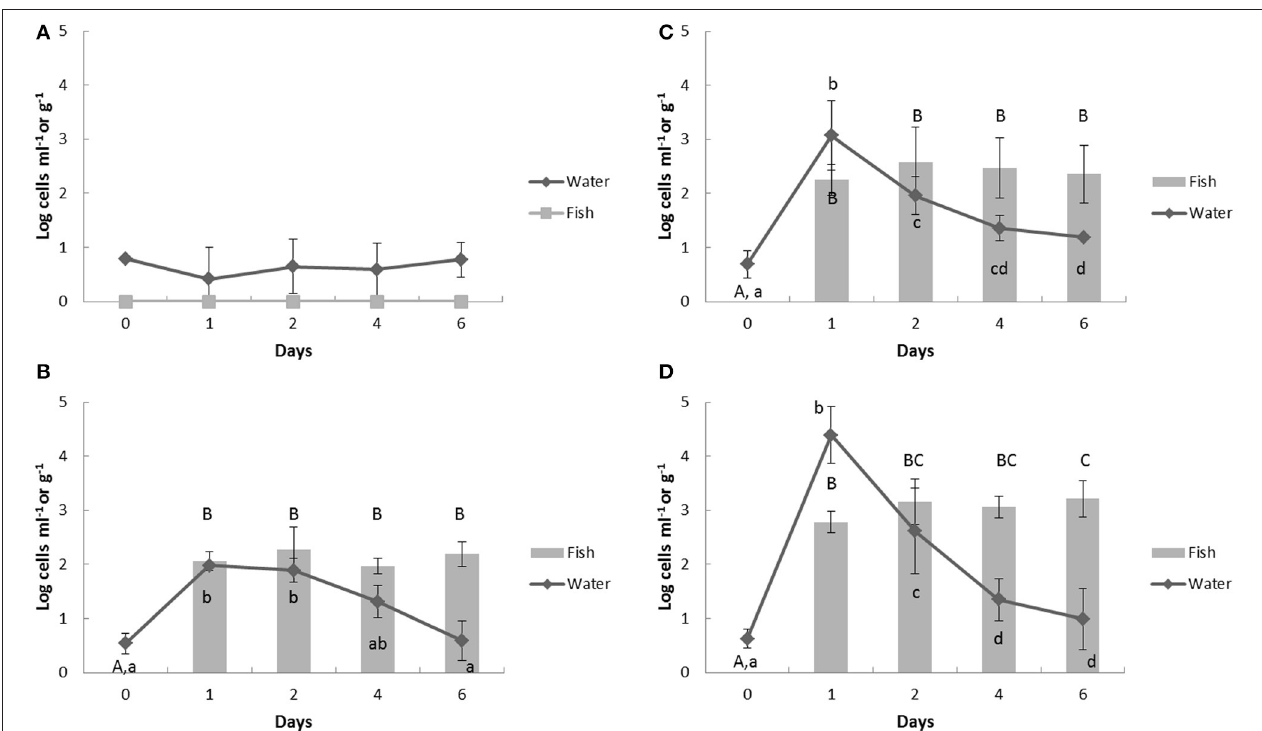
FIGURE 4 | Change of Vibrio parahaemolyticus counts in aquaculture water and fish by multiplex real-time PCR assay in response to heat- inactivated Vibrio spp. challenge. Bold (A) control group; (B) group 2; (C) group 3; (D) group 4. The Vibrio spp. were challenged in the aquaculture water at day 1 and the samples were collected at 24 h before the challenge (day 0), 1 h after challenge (day 1), and further 2, 4, 6 days. The upper case represents significantly different grouping among fish samples and lower case shows the significant grouping between water samples by Tukey